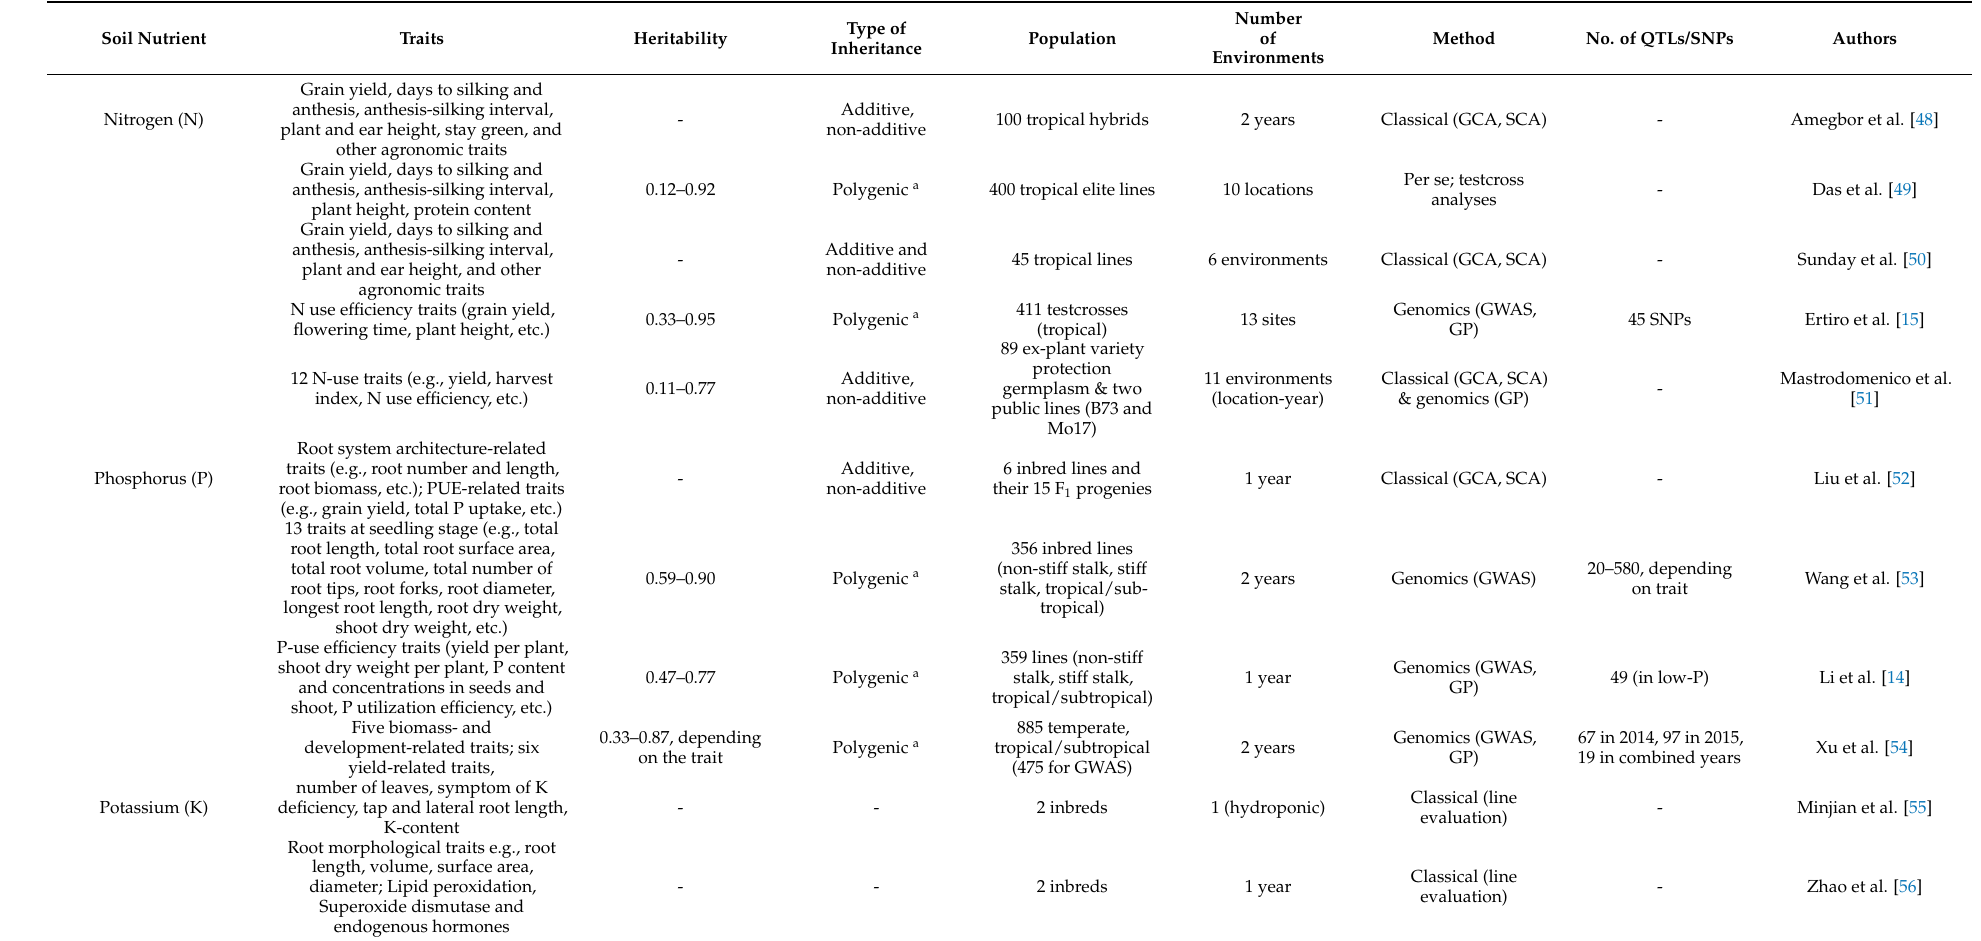
Table 1. Genetic and genomic parameters for traits associated with maize tolerance to suboptimal soil nitrogen, phosphorus and potassium